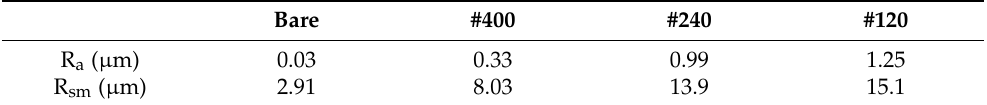
Table 1. Solid surface conditions. The arithmetical mean roughness value (R a ) ( µ m) and the mean peak width (R sm ) ( µ m) for each solid substrate.